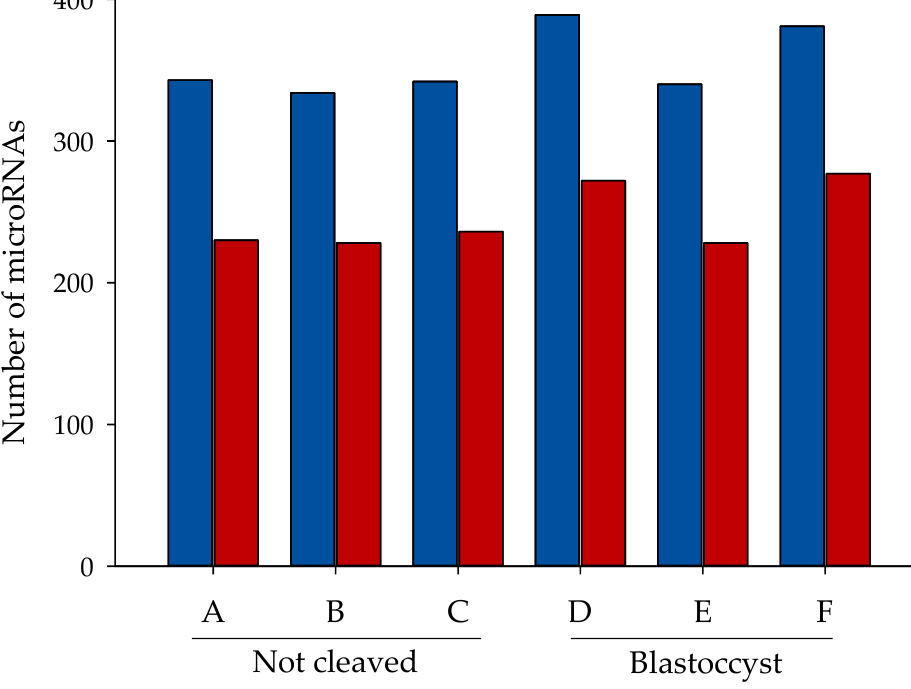
Figure 2. Number of miRNA reads. Number of known miRNAs with more than a given number of mapped reads: >0, but <50 reads per sample for blue bars and >50 per sample for red bars. A, B, C = cumulus pieces surrounding oocytes that failed to cleave after exposure to sperm; D, E, F = cumulus pieces surrounding oocytes that developed into blastocysts after fertilization. In short, cumulus cells harvested from the COCs of oocytes that failed to cleave after exposure to sperm and those that yielded a blastocyst showed a similar expression of miRNAs. Of all of the identified miRNAs, miR-21-5p was the most abundant (>2,000,000 reads, Table 2), but the number of reads was similar between the two groups. Different members of the let-7 family, miR-155 and miR-99a-5p also gave more than 100,000 reads in each group (Table 2).